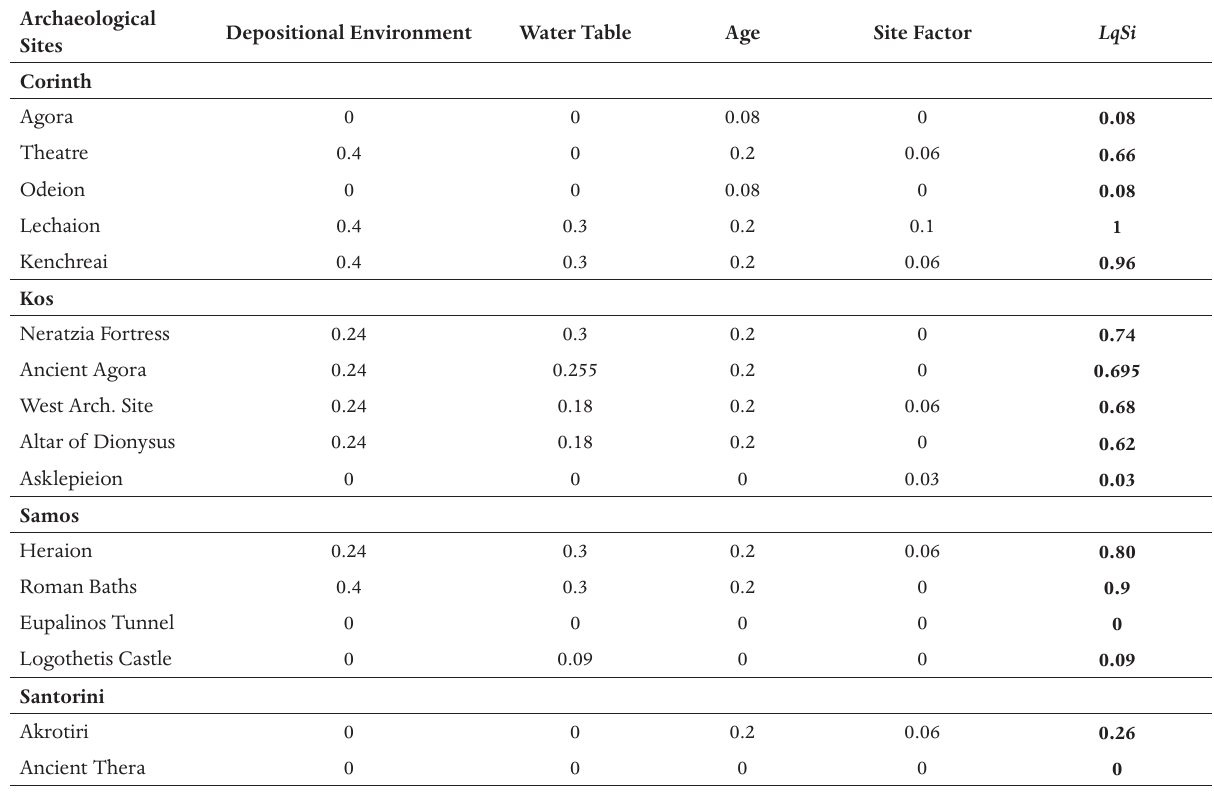
Table 1. Liquefaction Susceptibility indicator weighted factors and scores for the archaeological sites under study.